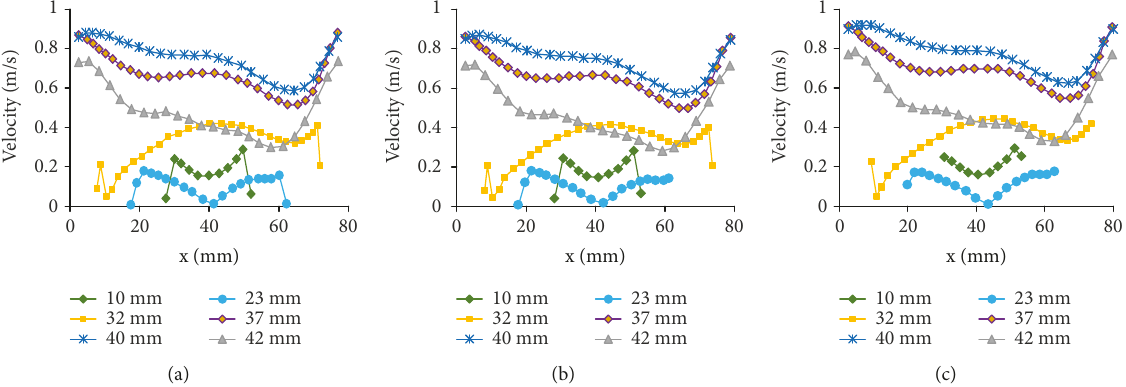
Figure 10: Velocity distribution of the polymer solution with a molecular weight of 1.6 × 10 6 dalton at 50m 3 /d when fl owing through the partially pressured injection tool with 5